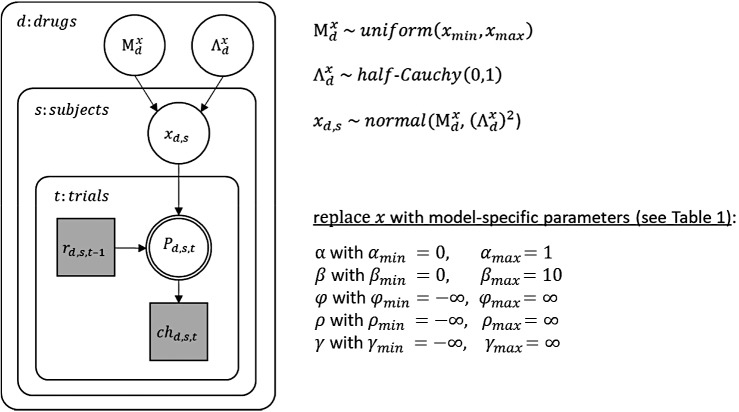
Graphical description of the hierarchical Bayesian modeling scheme.In this graphical scheme, nodes represent variables of interest (squares: discrete variables; circles: continuous variables) and arrows indicate dependencies between these variables. Shaded nodes represent observed variables, here rewards (r) and choices (ch) for each trial (t), subject (s), and drug condition (d). For each subject and drug condition, the observed rewards until trial t-1 determine (deterministically) choice probabilities (P) on trial t, which in turn determine (stochastically) the choice on that trial. The exact dependencies between previous rewards and choice probabilities are specified by the different cognitive models and their model parameters (x). Note that the double-bordered node indicates that the choice probability is fully determined by its parent nodes, that is the reward history and the model parameters. As the model parameters differ between all applied cognitive models, they are indicated here by an x as a placeholder for one or more model parameter(s). Still, the general modeling scheme was the same for all models: Model parameters were estimated for each subject and drug condition and were assumed to be drawn from a group-level normal distribution with mean Mx and standard deviation Λx for any parameter x. Note that group-level parameters were estimated separately for each drug condition. Each group-level mean (Mx) was assigned a non-informative (uniform) prior between the limits xmin and xmax as listed above. Each group-level standard deviation (Λx) was assigned a half Cauchy distributed prior with location parameter 0 and scale 1. Subject-level parameters included α,β,φ, ρ, and γ depending on the cognitive model (see Table 1).